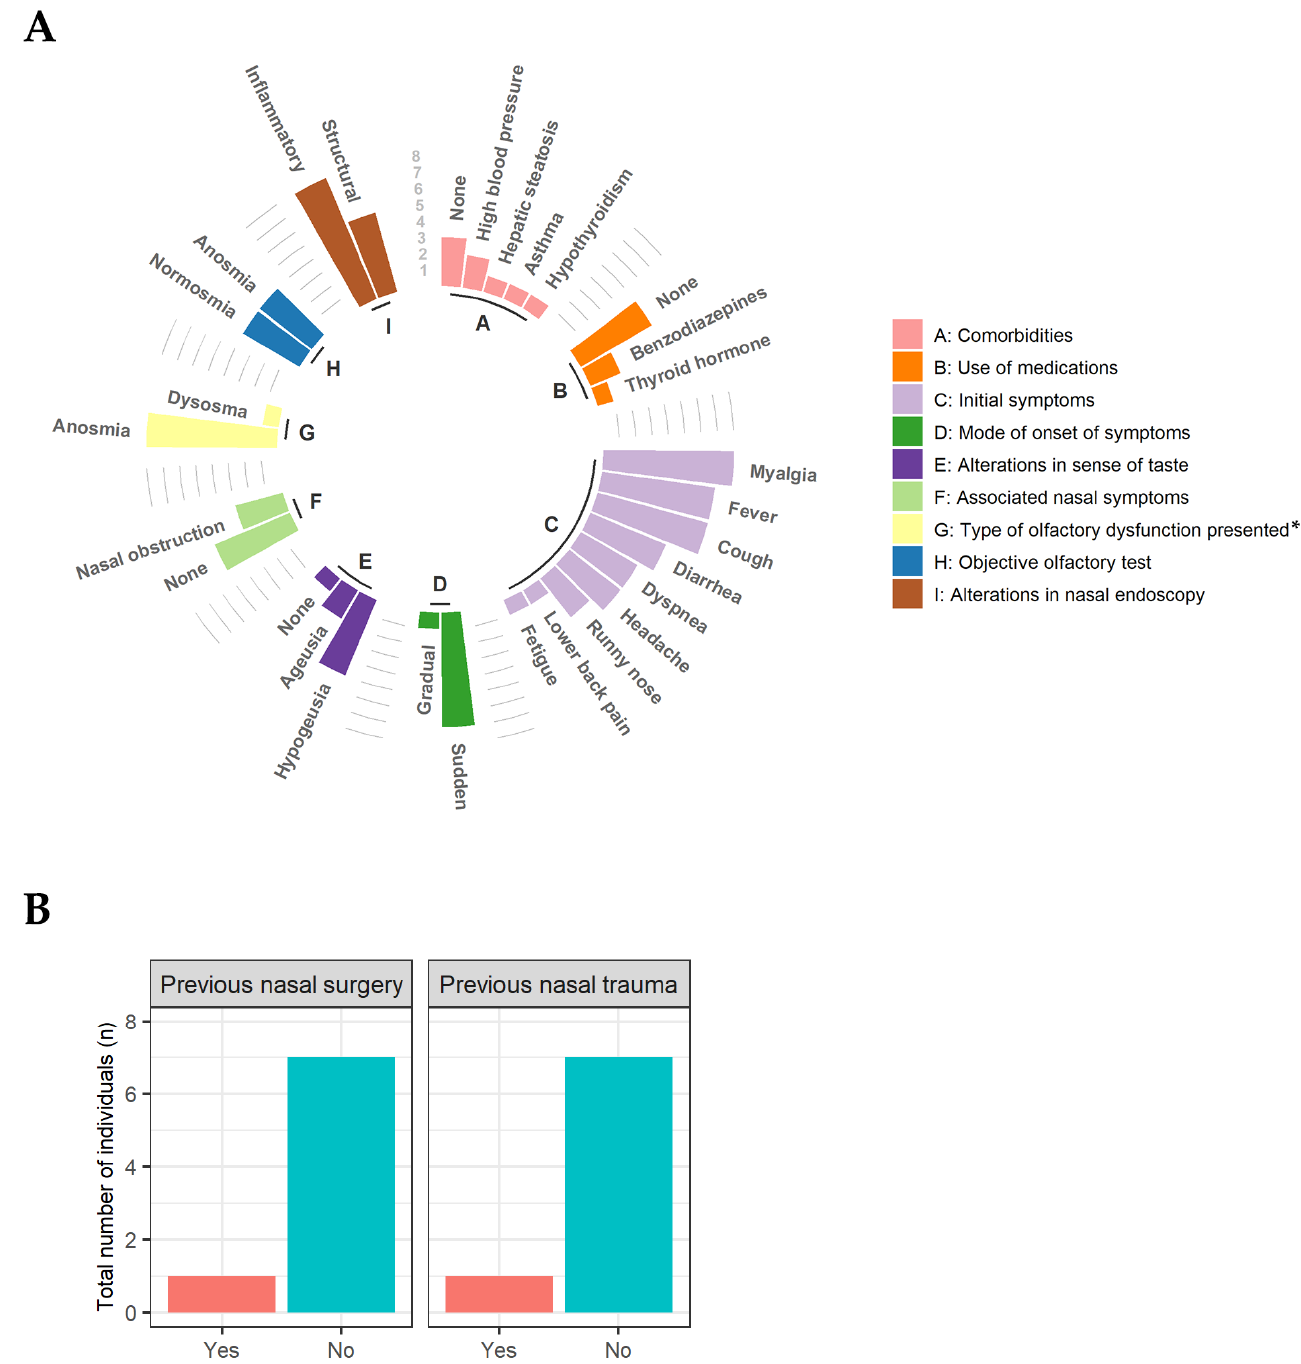
Figure 2. Clinical characteristics of patients complaining of mild post-COVID-19 olfactory disorders. ( A ) absolute frequency of clinical symptoms observed during application of the clinical-epidemiological questionnaire (A, B, C, D, E, F, G) and otorhinolaryngological physical examination (H, I). The letters inside the circle represent the X -axis and indicate which group each variable belongs to. The lines between the groups represent the Y -axis and indicate the absolute frequency of each variable. ( B ) Absolute frequency of surgery and previous nasal trauma. * patients’ perception of symptoms.